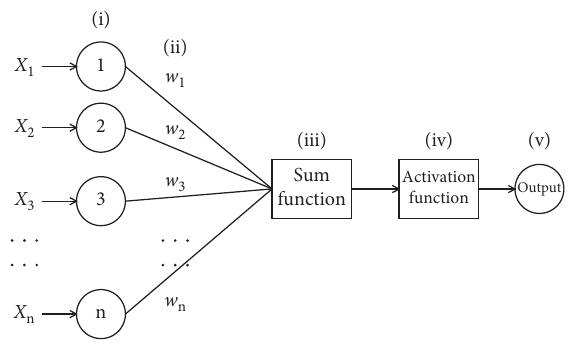
Figure 2: A simple neuron architecture.